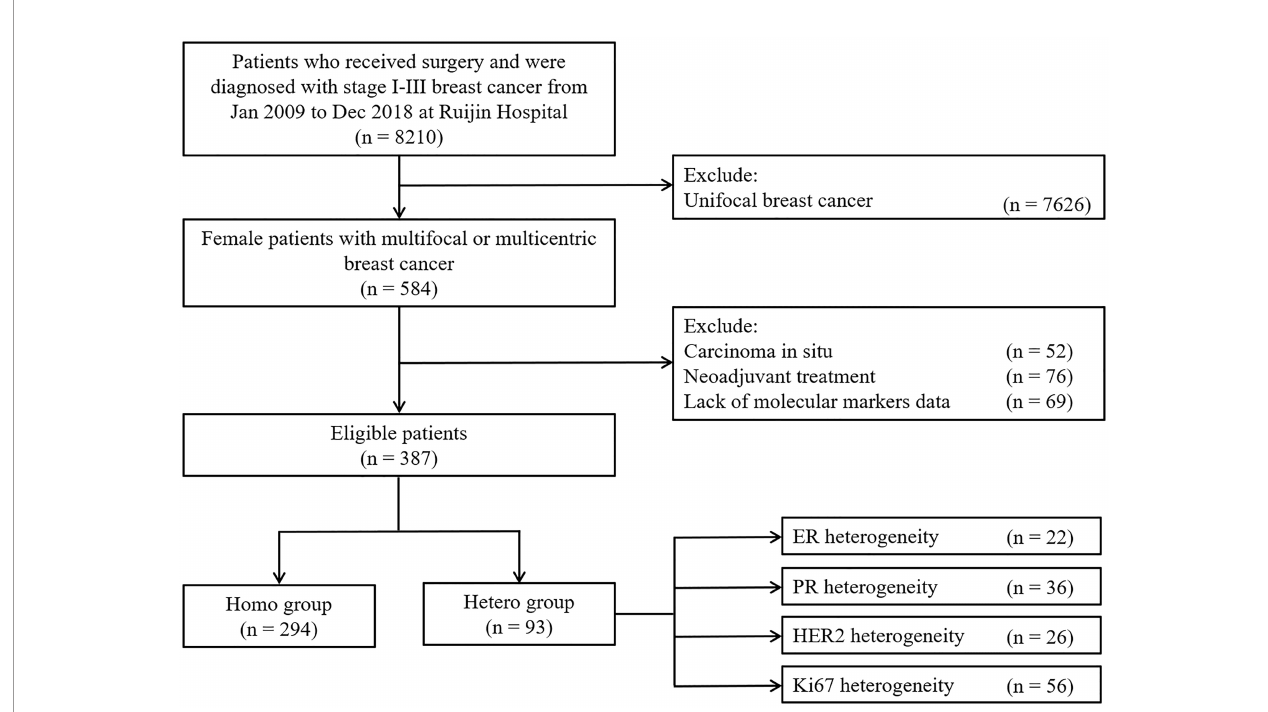
FIGURE 1 | Flow chart of 387 patients in the